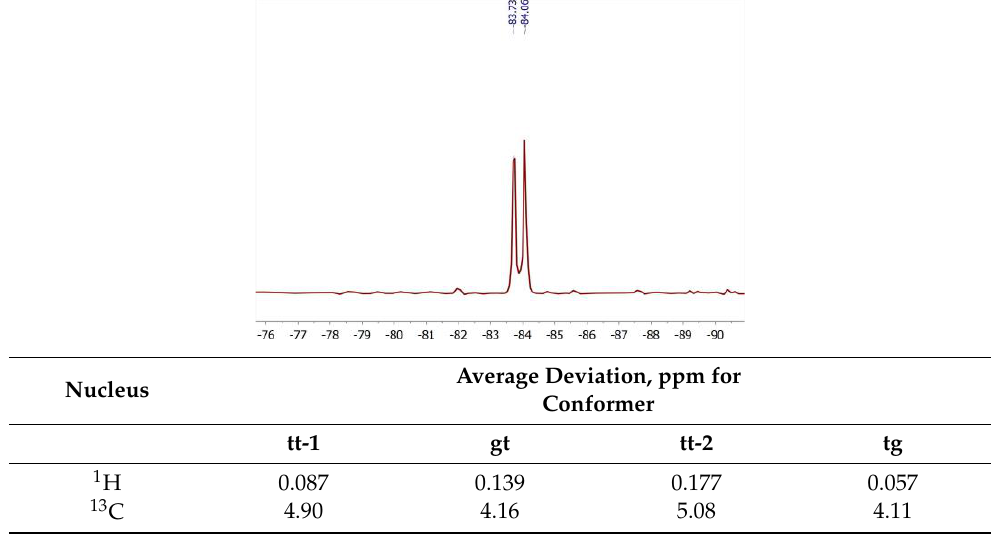
Figure 2. Structure of CPDA conformers and direction of dipole moments.